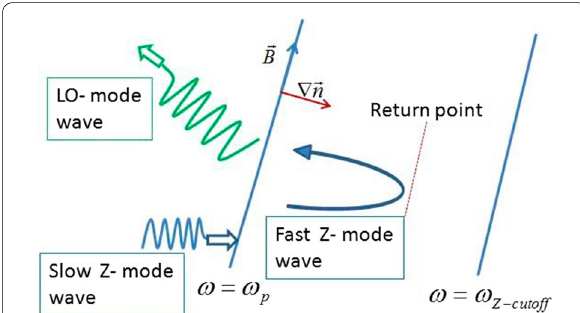
Fig. 1 A schematic representation of the slow Z-mode wave propagation in an inhomogeneous plasma and mode conversion processes